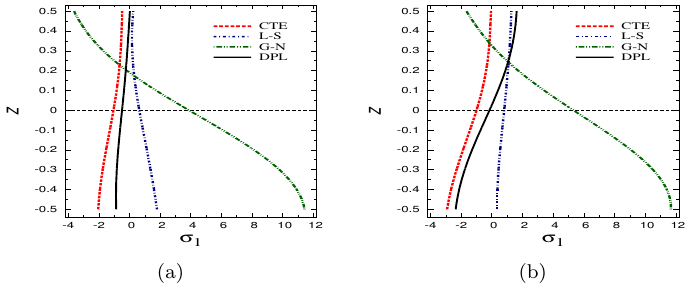
Figure 9. The axial normal stress distributions in the thickness direction for beams under (a) thermal load and (b) thermomechanical load.